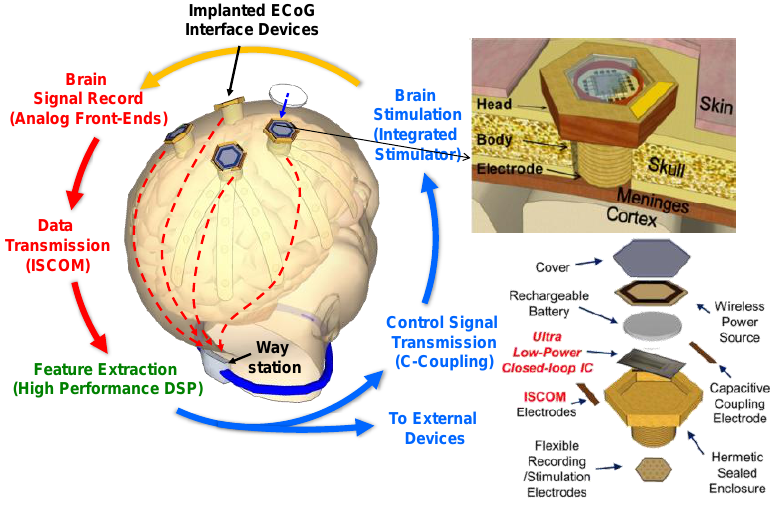
Figure 1. System concept for distributed wireless ECoG recordings.